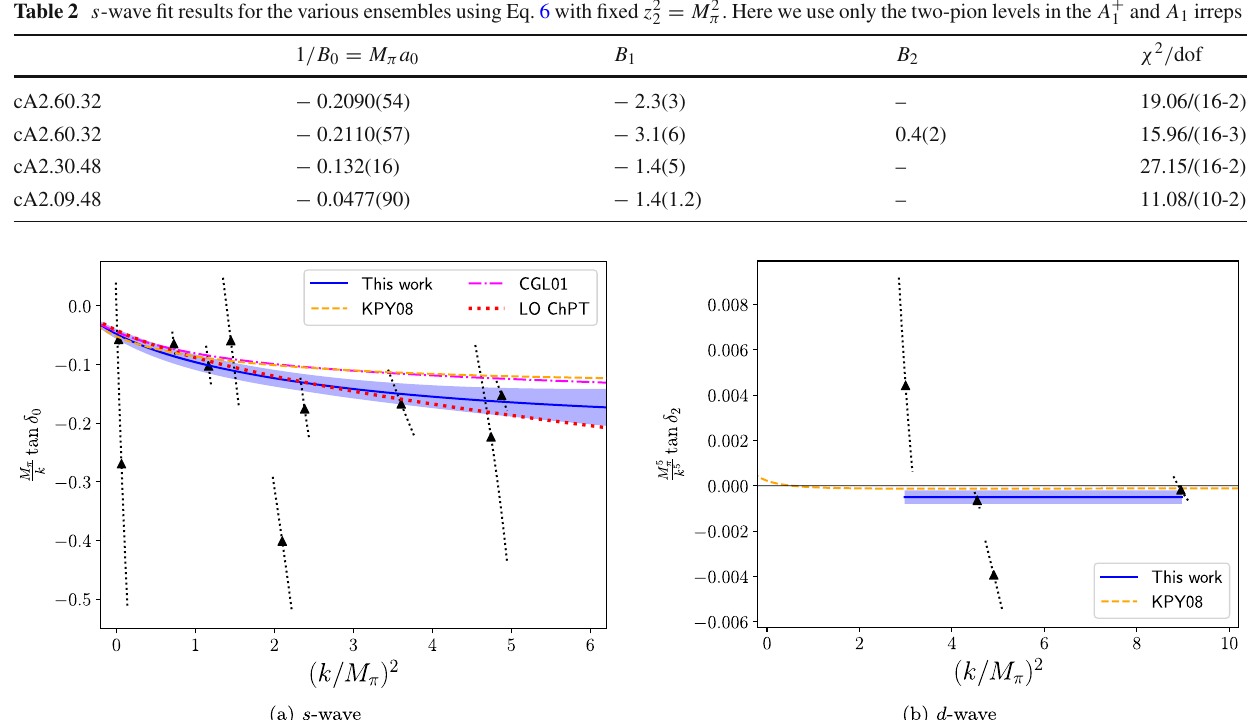
Table 2 s -wave fit results for the various ensembles using Eq. 6 with fixed z 2